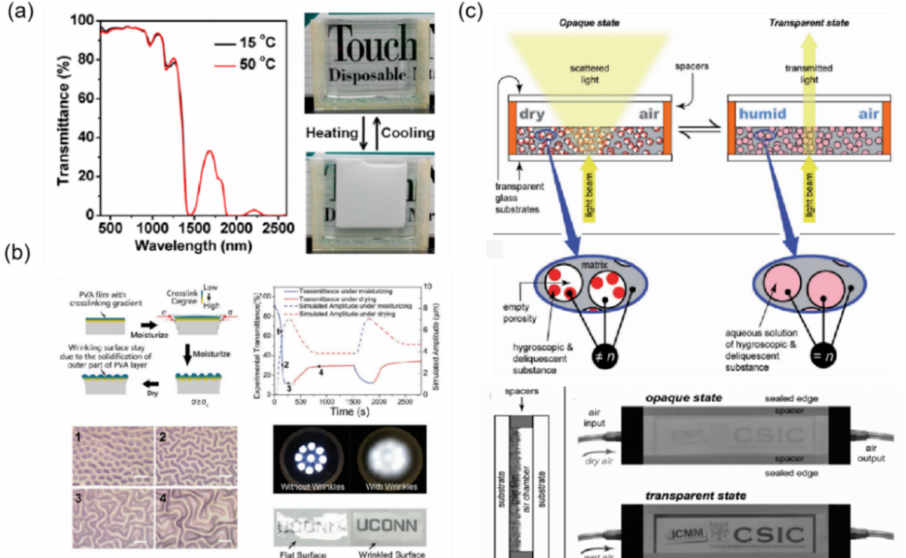
Figure 12. The strategy of humidity driving mode mechanoresponsive smart windows: ( a ) based on thermosensitive hydrogels [73] Copyright 2014, American Chemical Society, ( b ) based on the humidity driving mode wrinkles [74] Copyright 2017, John Wiley and Sons, ( c ) base on humidity sensitive porous structure [75] Copyright 2018, John Wiley and Sons.